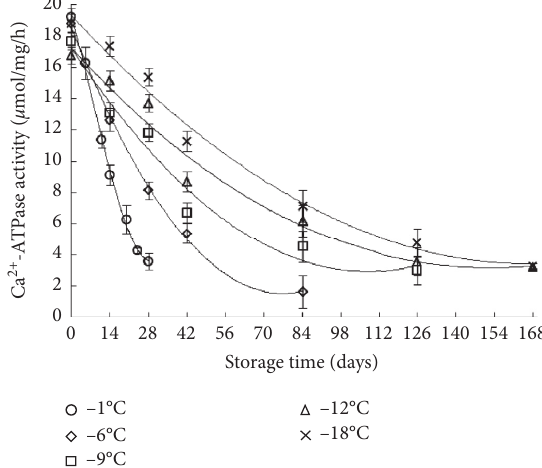
Figure 3: Changes in the Ca 2+ -ATPase activity of beef MP during storage at − 1, − 6, − 9, − 12, and − 18 ° C.